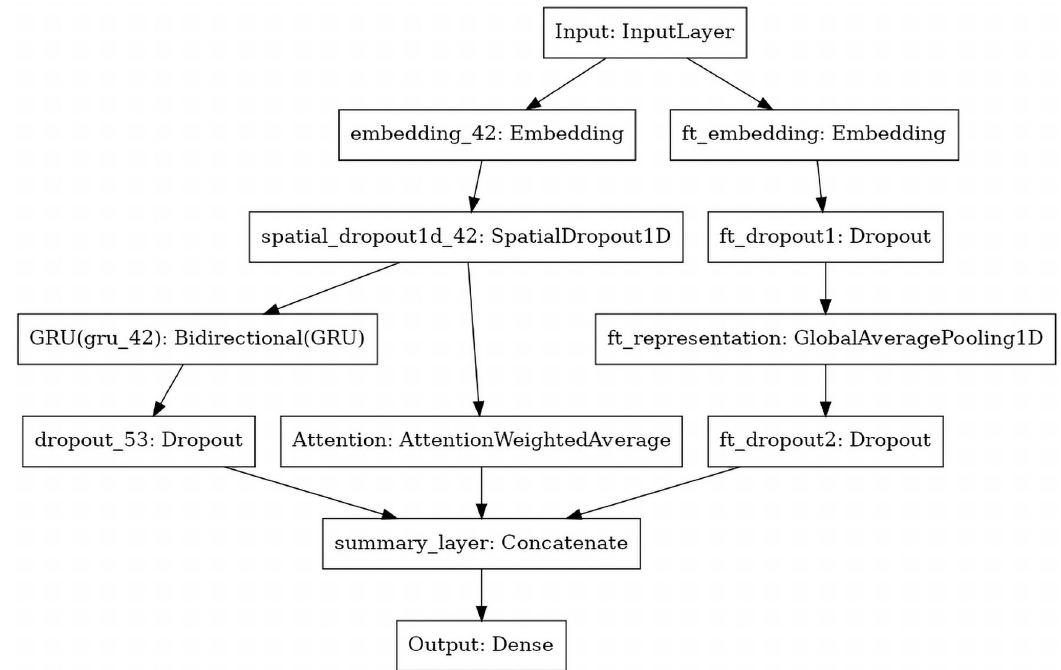
Fig 8. Representation of the final classifier. An initial input layer, in which strings are represented by a sequence of one-hot encoded words, is passed to a) a deep neural network similar to the DeepMoji classifier [70], and b) a fasttext classifier [71]. After being pre-trained to predict hashtags from the surrounding text (source dataset), the model is fine-tuned to instead predict vaccine sentiment from tweet text (target dataset).